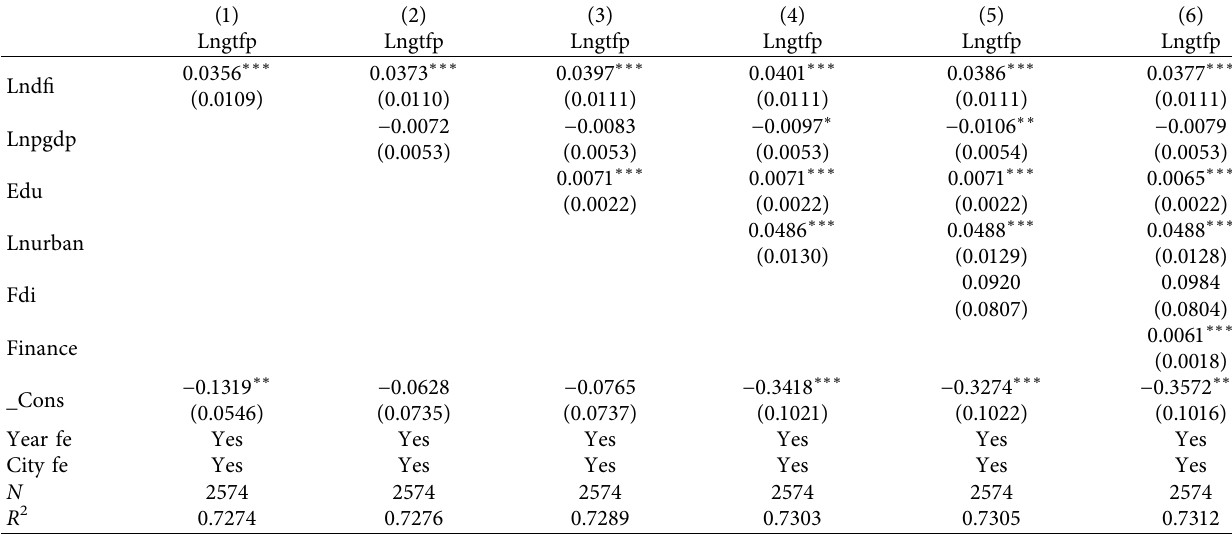
Table 3: Influence of digital finance on green